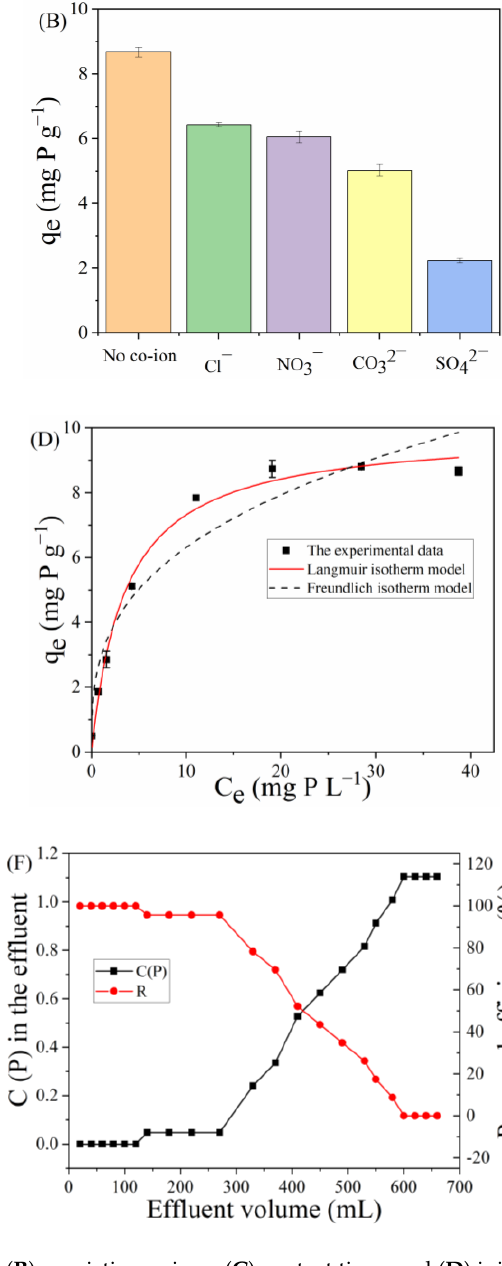
Figure 6. The influence of ( A ) pH, ( B ) coexisting anions, ( C ) contact time, and ( D ) initial phosphate concentration on phosphate removal by PAN A F-FeOOH. ( E ) Reusability of PAN A F-FeOOH for phosphate removal and ( F ) breakthrough curves of phosphate solutions in continuous flow condi-